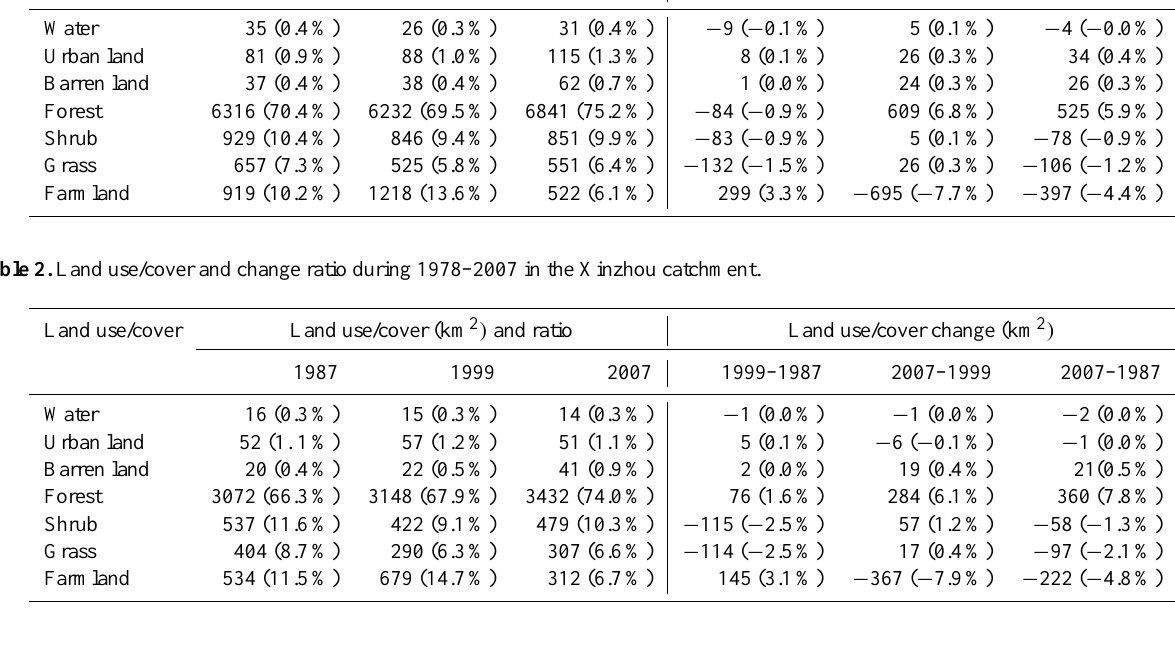
Table 3. Variables and associated abbreviations used in the statisti- cal